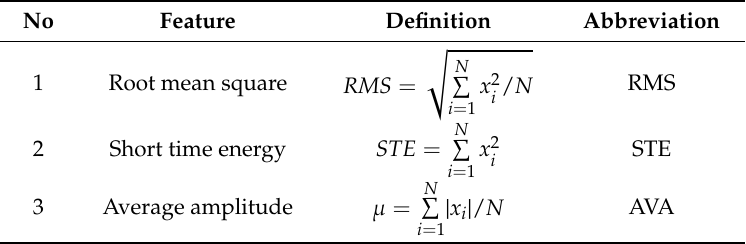
Table 3. Typical features.